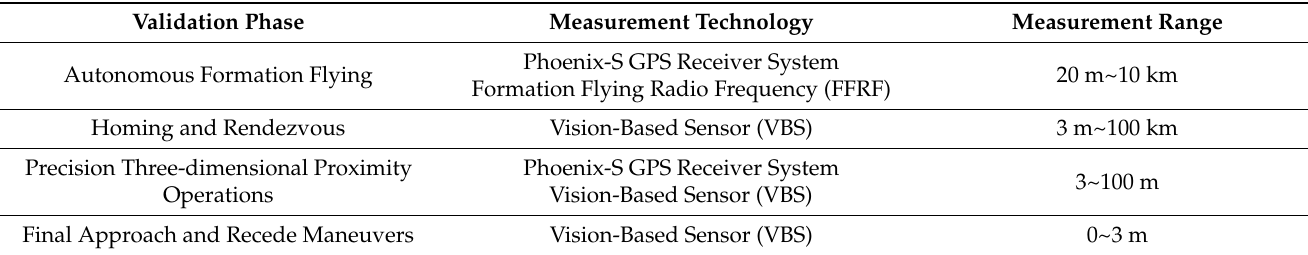
Table 2. SAFE verification phases.